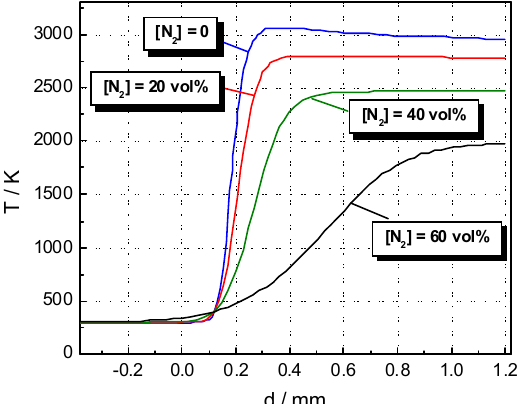
Figure 2. Temperature profiles of the flame front of N 2 -diluted stoichiometric H 2 –N 2 O flames with various nitrogen concentrations under ambient initial conditions.